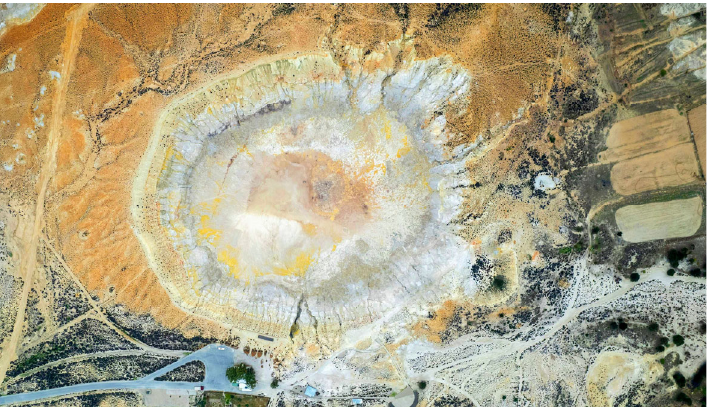
Figure 4. Stefanos is the largest hydrothermal crater of Nisyros and one of the largest of its kind in the world. Its dimensions are 260 m × 350 m, with a depth of 27 m and an estimated age of more than 600 years.